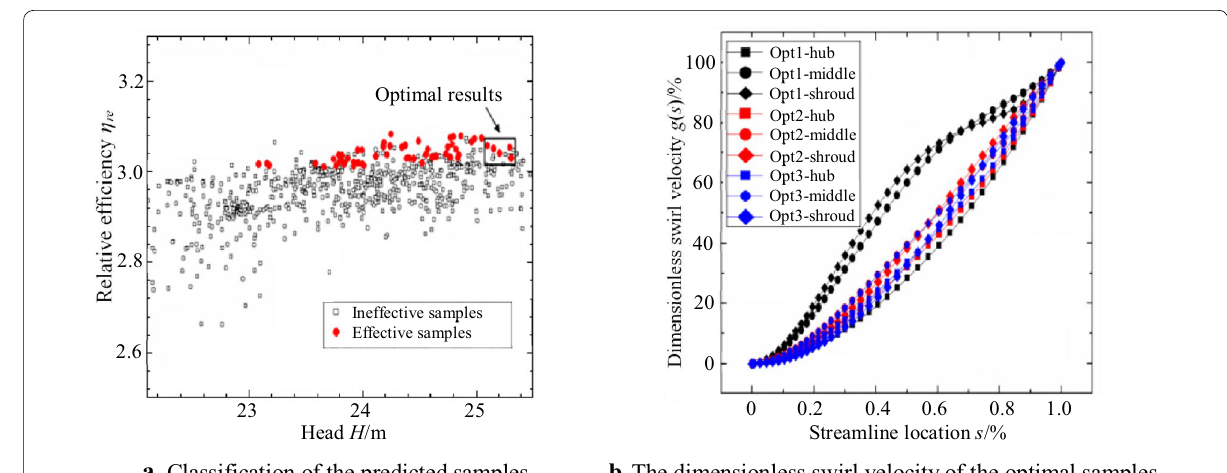
Figure 9 Results obtained with the NSGA‑II